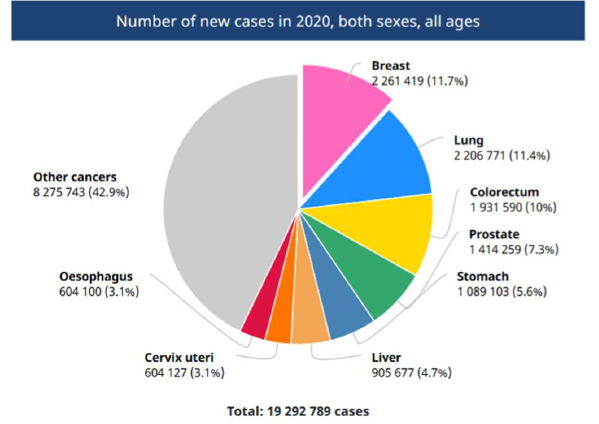
Figure 1. Number of cases in the world [4]